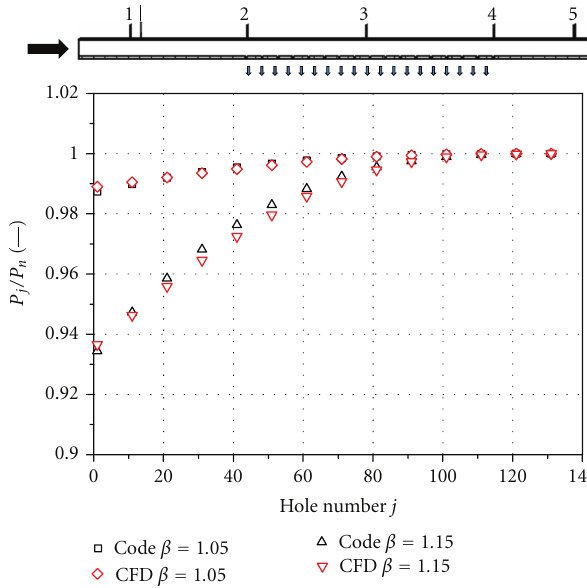
Figure 8: Pressure distribution for Geom